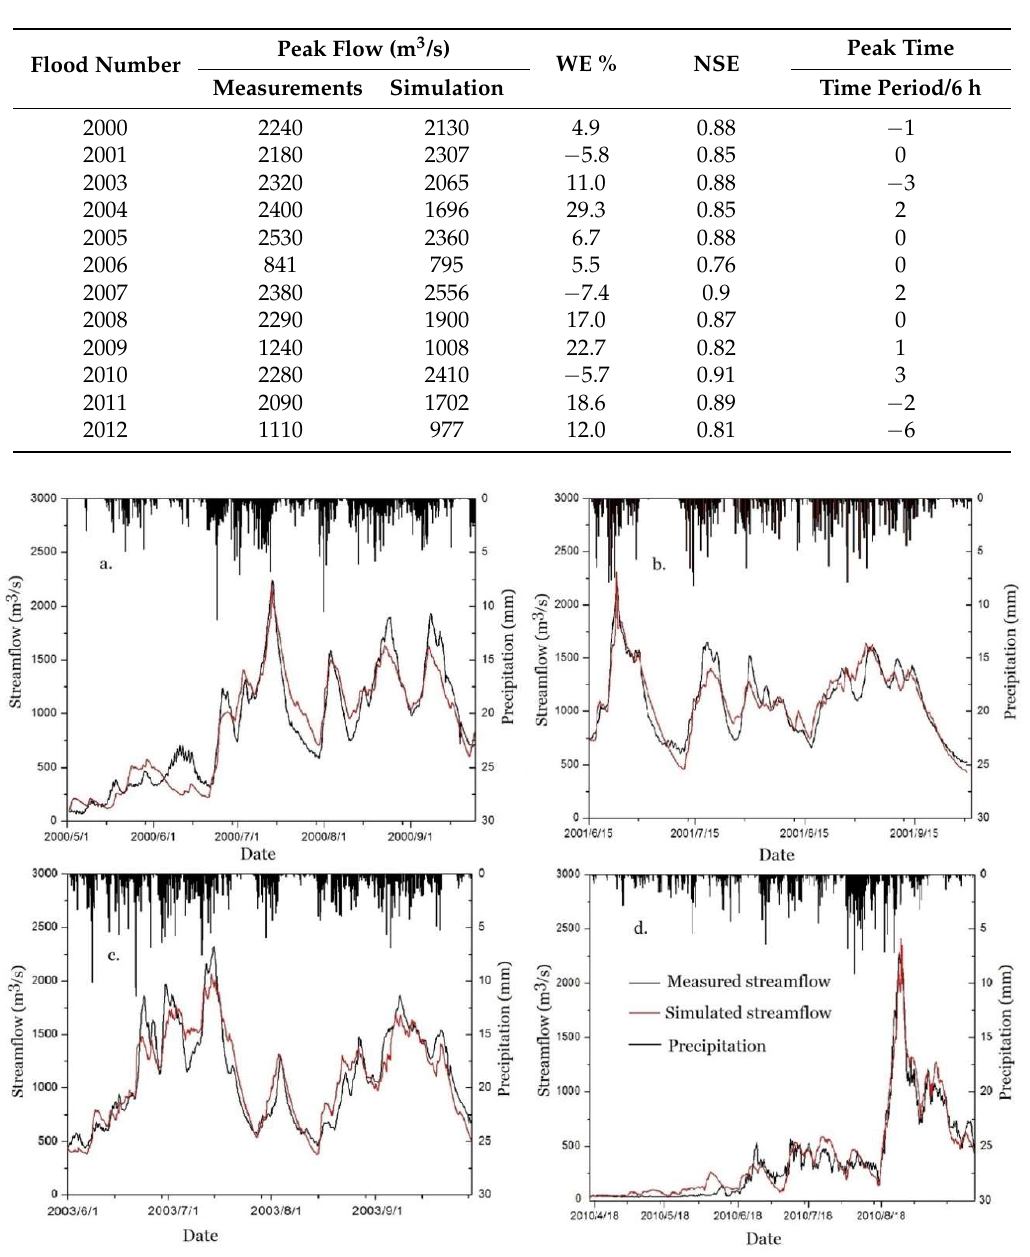
Figure 7. Comparisons between simulated and measured streamflow at hourly time step. ( a ) Strom events simulation in 2000; ( b ) Strom events simulation in 2001; ( c ) Strom events simulation in 2003; ( d ) Strom events simulation in 2010.